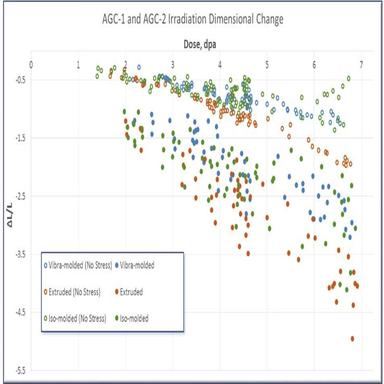
Irradiation dimensional change for AGC specimens irradiated to a dose of 7 dpa at 600 °C.